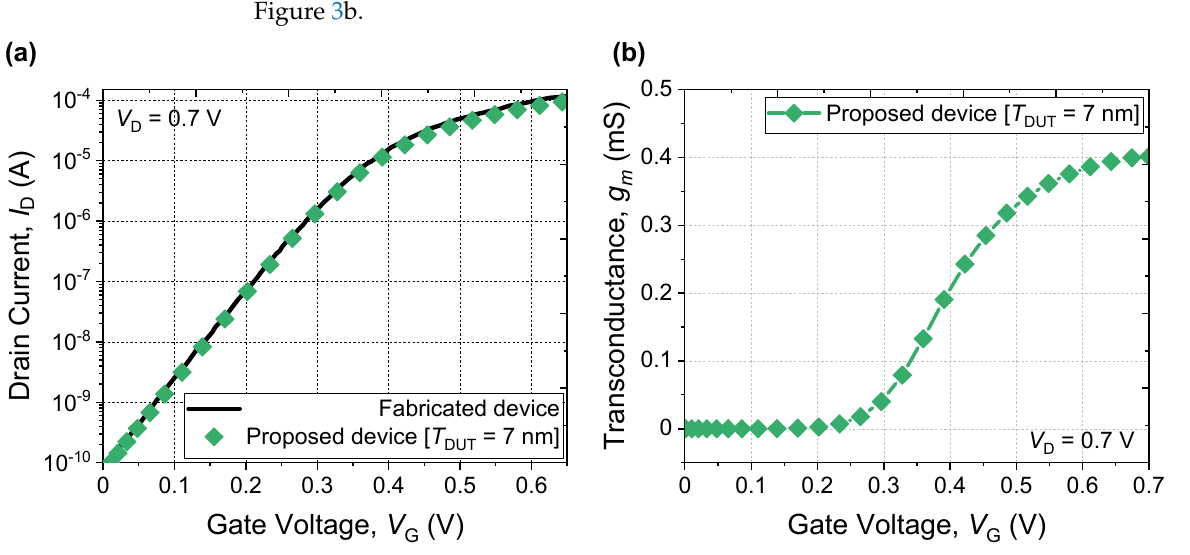
Figure 3. ( a ) Calibration of I D − V G curve with the fabricated device in Reference [6]. ( b ) Transconductance of Figure 3a.